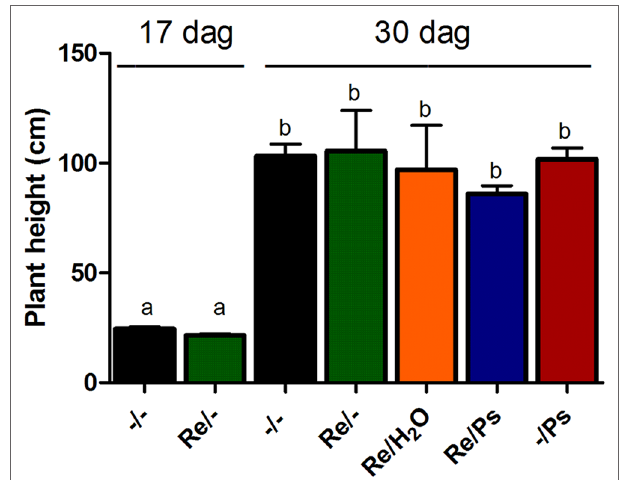
FIGURE 3 | Plant height before pathogen inoculation and 13 days after infection (17 and 30 dag, respectively). Data are mean ± SEM from 24 independent (n = 24) plants per treatment, from two independent experiments, and were analyzed with one-way ANOVA followed by Tukey’s multiple comparison tests (P < 0.05). Means with the same letter are not significantly